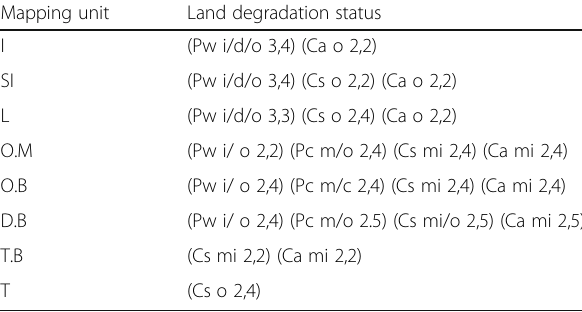
Table 14 Land degradation status in the different mapping